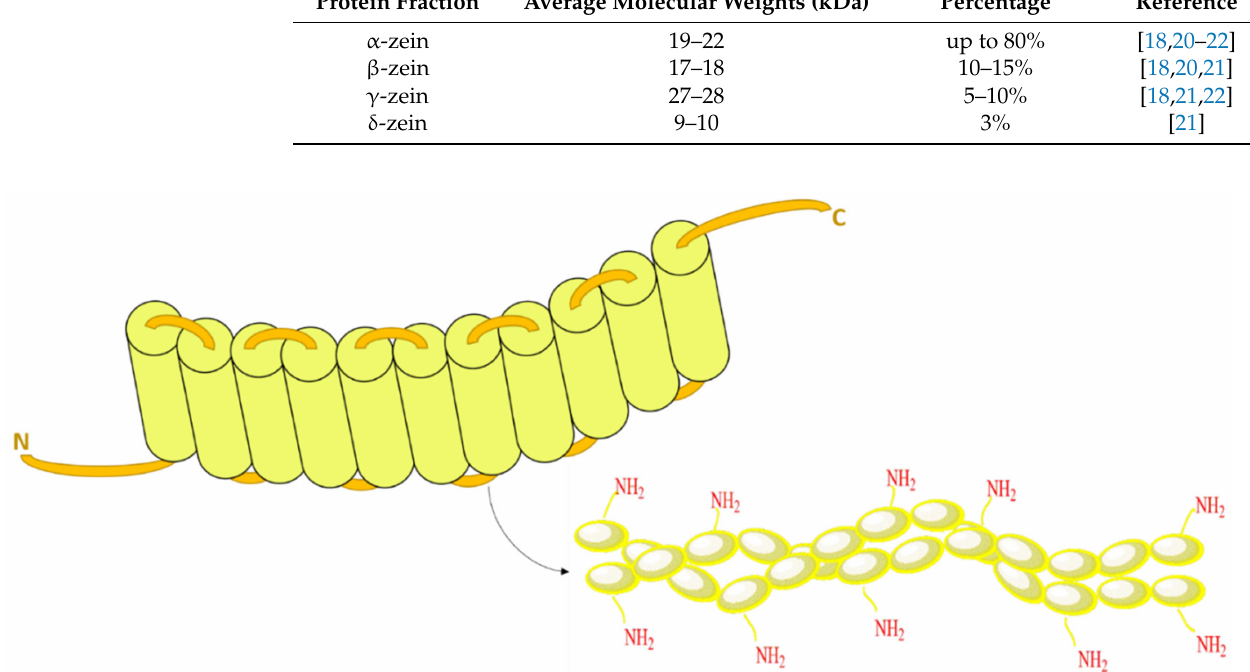
Figure 1. Hypothetical view of the tandem repeat units formed by single α - helix presented by cylinders and the abundant amine functionalities on the glutamine rich turns (loops) joining